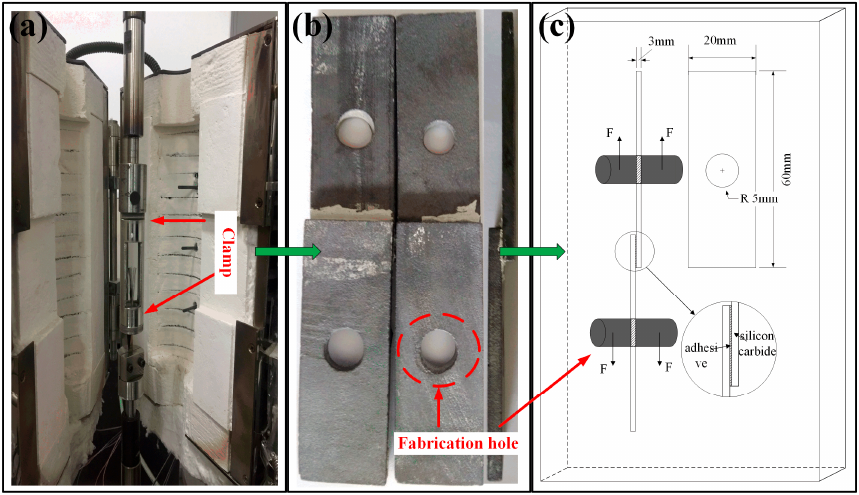
Figure 4. Shear strength test of the SLJ. ( a ) fixture diagram; ( b ) fabrication hole in specimens; ( c ) tensile test diagrammatic drawing.